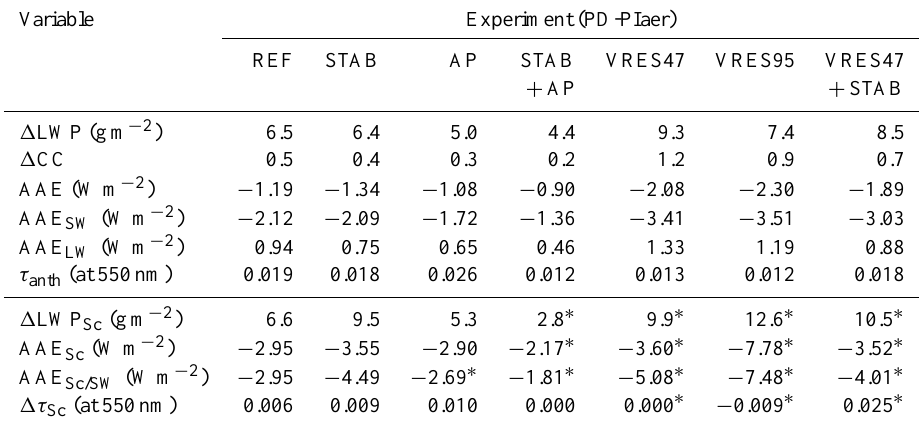
Table 3. Changes in aerosol, cloud and forcing parameters between simulations with preindustrial and present-day aerosol for all experiments. Global values and values in the stratocumulus regime are given. Note that the results with L47bl and L95bl are from 1-year simulations. LWP is liquid water path, CC is cloud cover, AAE is the anthropogenic aerosol effect, τ anth is the anthropogenic aerosol optical depth and 1τ is the change in aerosol optical depth. The subscript Sc represents values in the stratocumulus regime. Values marked by ∗ are not statistically significant or could not be tested for statistical